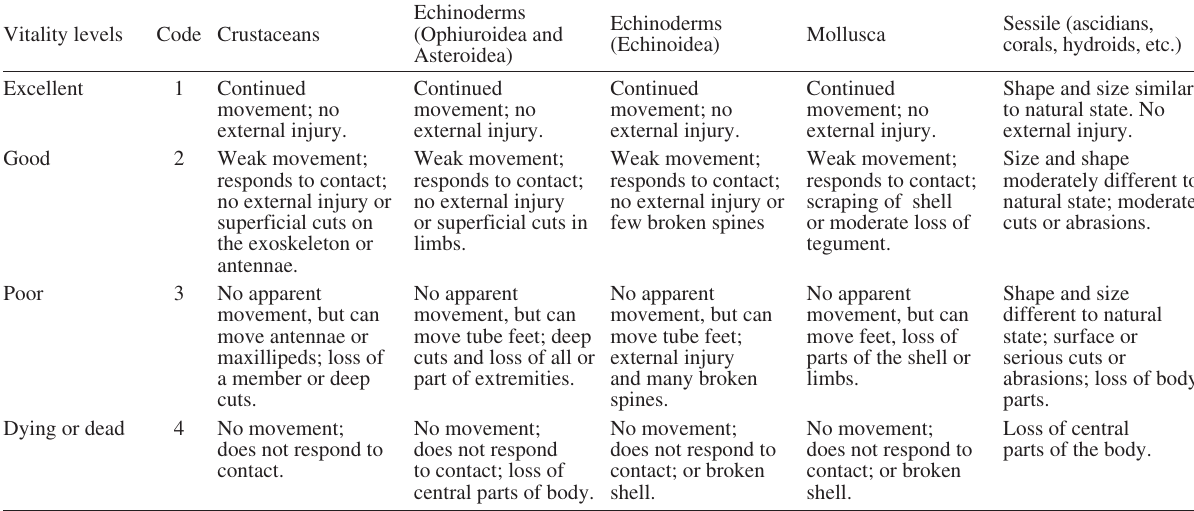
Table 2. – Description of vitality levels of invertebrate organisms for a semi-quantitative assessment approach by groups of likely animals (From ICES 2014 and Demestre 2012). Vitality